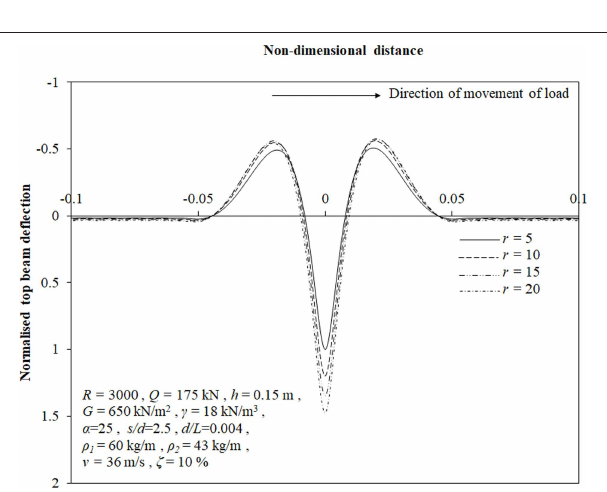
FIGURE 8 | Deflection profile of top beam at different values of r .